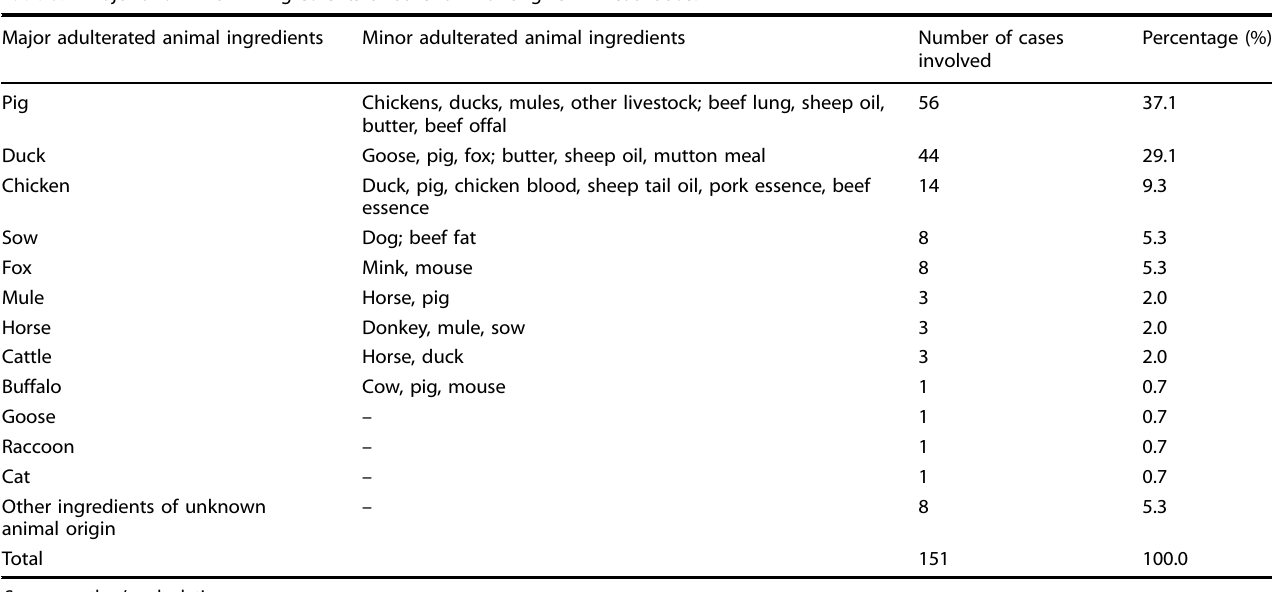
Table 5. Major and minor FF ingredients of other animal origins in meat foods.